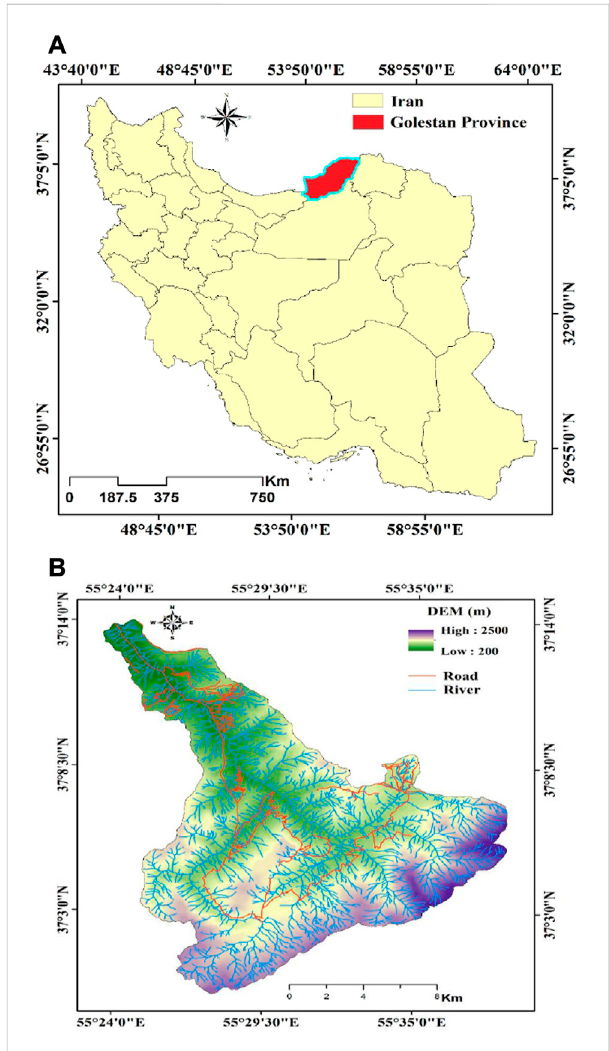
FIGURE 1 Geographical location of thestudy area (A) Golestan province on map of Iran (B) Chehelchay watershed of Golestan